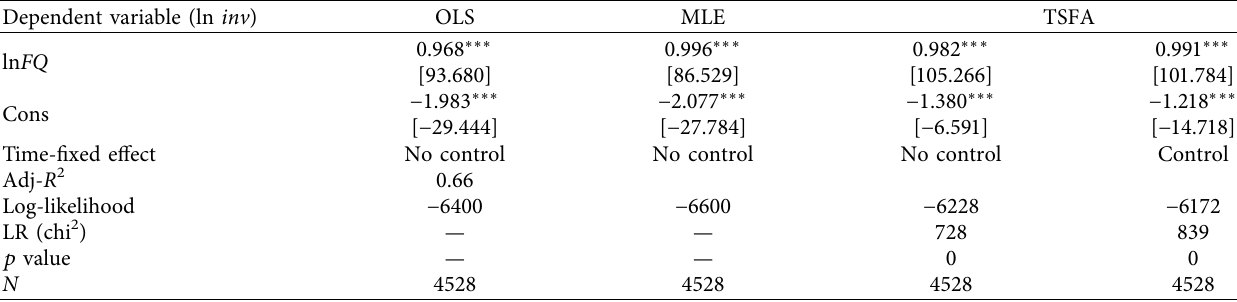
Table 3: Parameter estimates of infrastructure investment and construction efciency model.